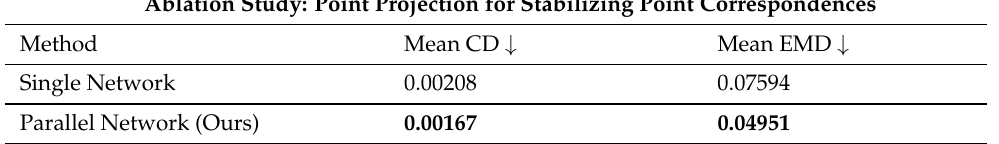
Table 4. Overall results on the DALES Viewpoints dataset comparing the original SA-Net implemen- tation with the same implementation and our proposed point correspondence